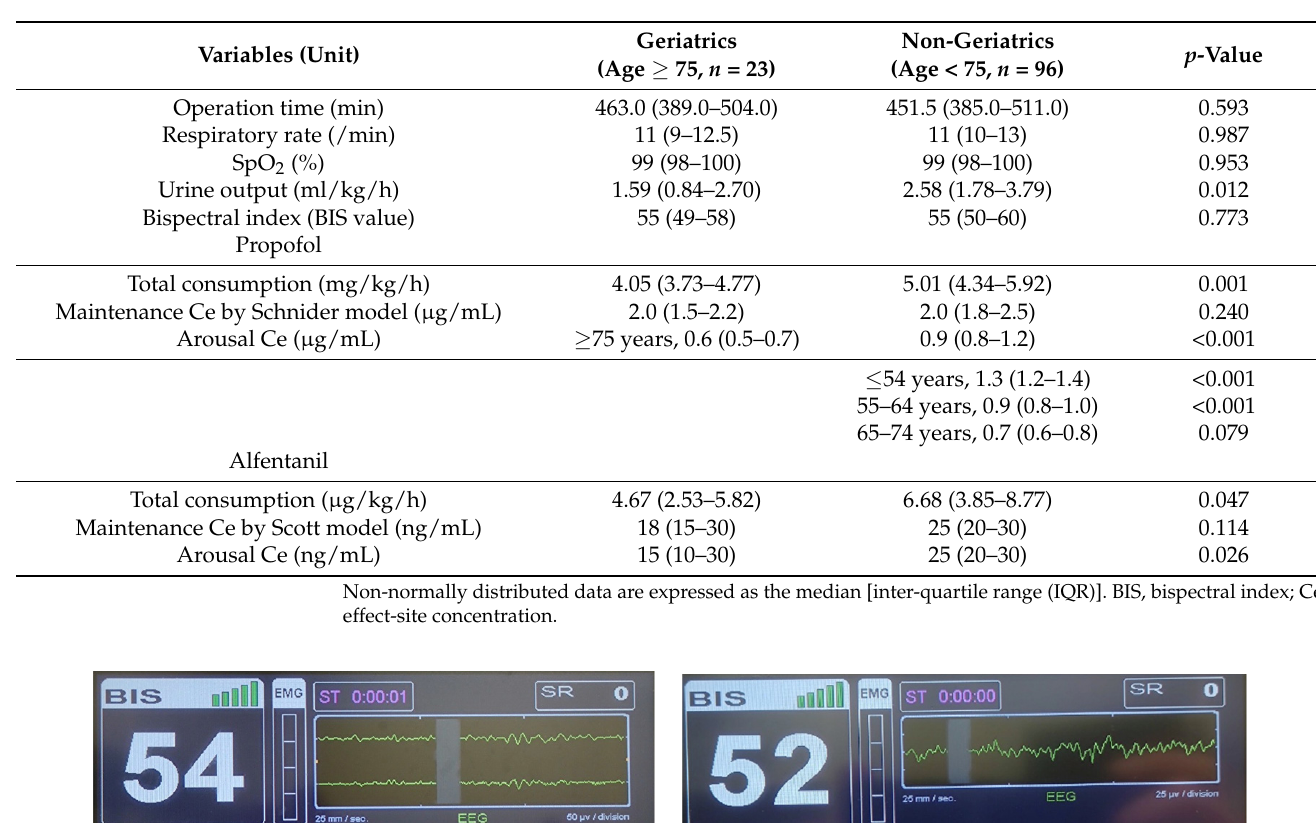
Table 3. BIS-guided non-intubation total intravenous anesthesia with target-controlled infusion.